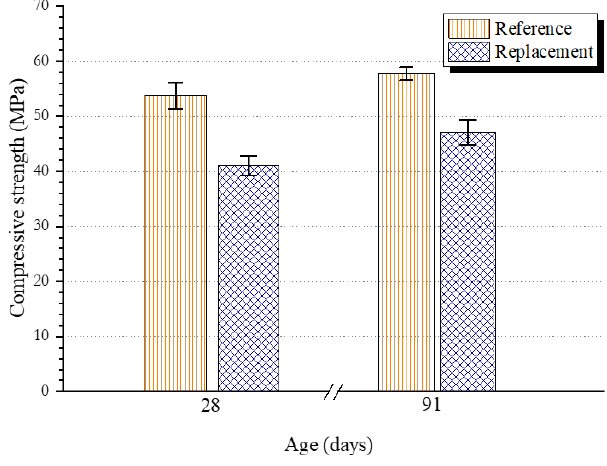
Figure 4. Results of the compressive strength test at 28 and 91